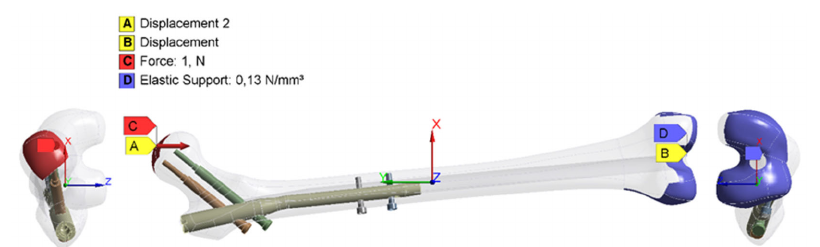
Figure 10. Boundary conditions.